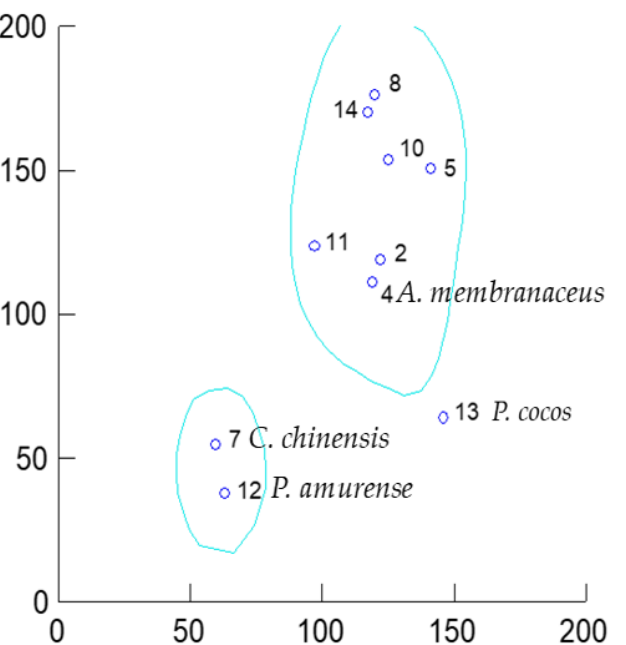
Figure 16. Scatterplot of the antioxidant activity (α values in X axis) vs. eicosanoids inhibition ( χ values, Y axis) of the extracts. Numbers denote the species as per Table 2. Only key species for discussion are named here.